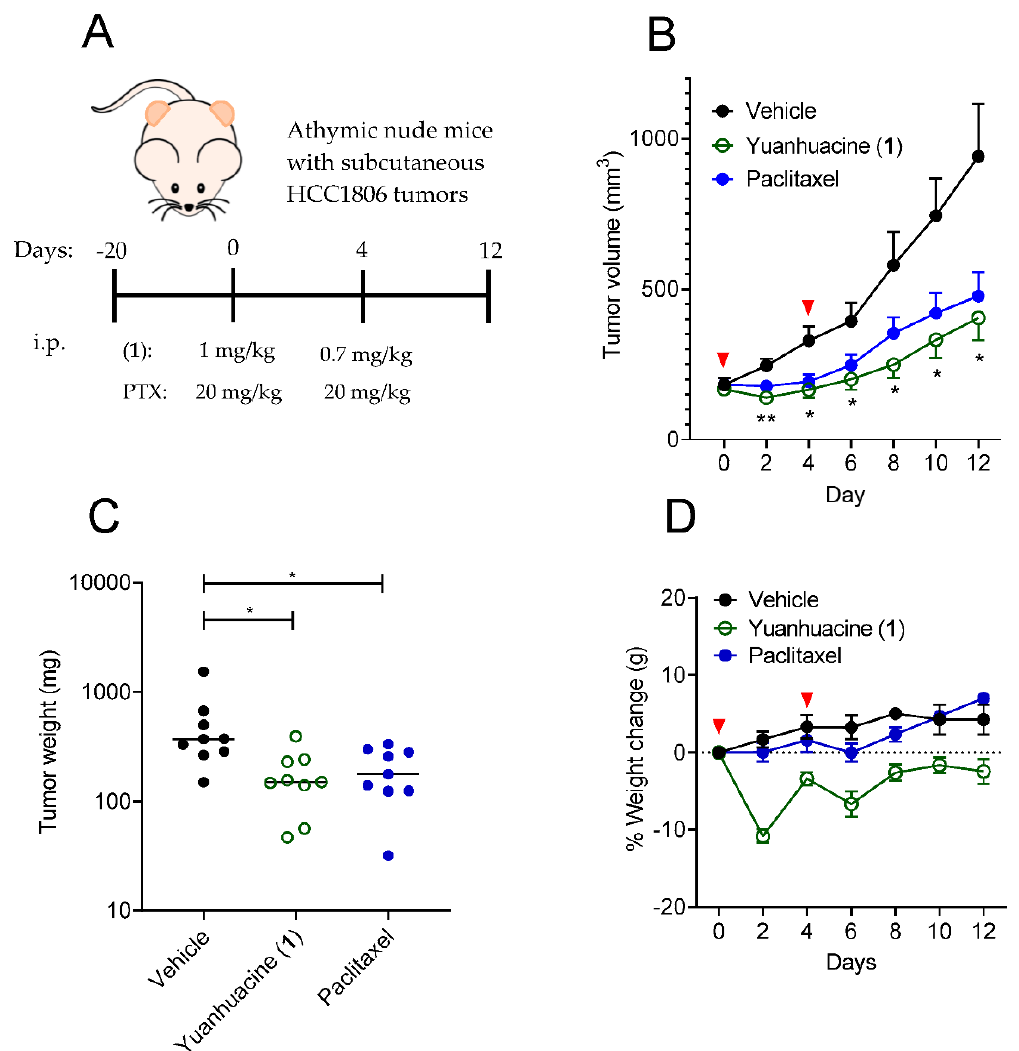
Figure 6. Yuanhuacine exhibits antitumor activity against a xenograft model of the BL2 subtype of TNBC. ( A ) Timeline of the antitumor trial. ( B ) Growth of HCC1806 flank xenograft tumors in athymic mice treated by i.p. injection with 1 (1 mg/kg day 0 and 0.7 mg/kg day 4), PTX (20 mg/kg days 0 and 4) or vehicle. Red arrows indicate days animals were dosed. Significance determined by 2-way ANOVA with Tukey’s posthoc test. * p < 0.05, ** p < 0.01. ( C ) The weight of tumors collected at day 12. Significance determined by 1-way ANOVA with Dunnett’s posthoc test. * p < 0.05. ( D ) Percent change in weight during the course of the trial. Red arrows indicate days animals were dosed.